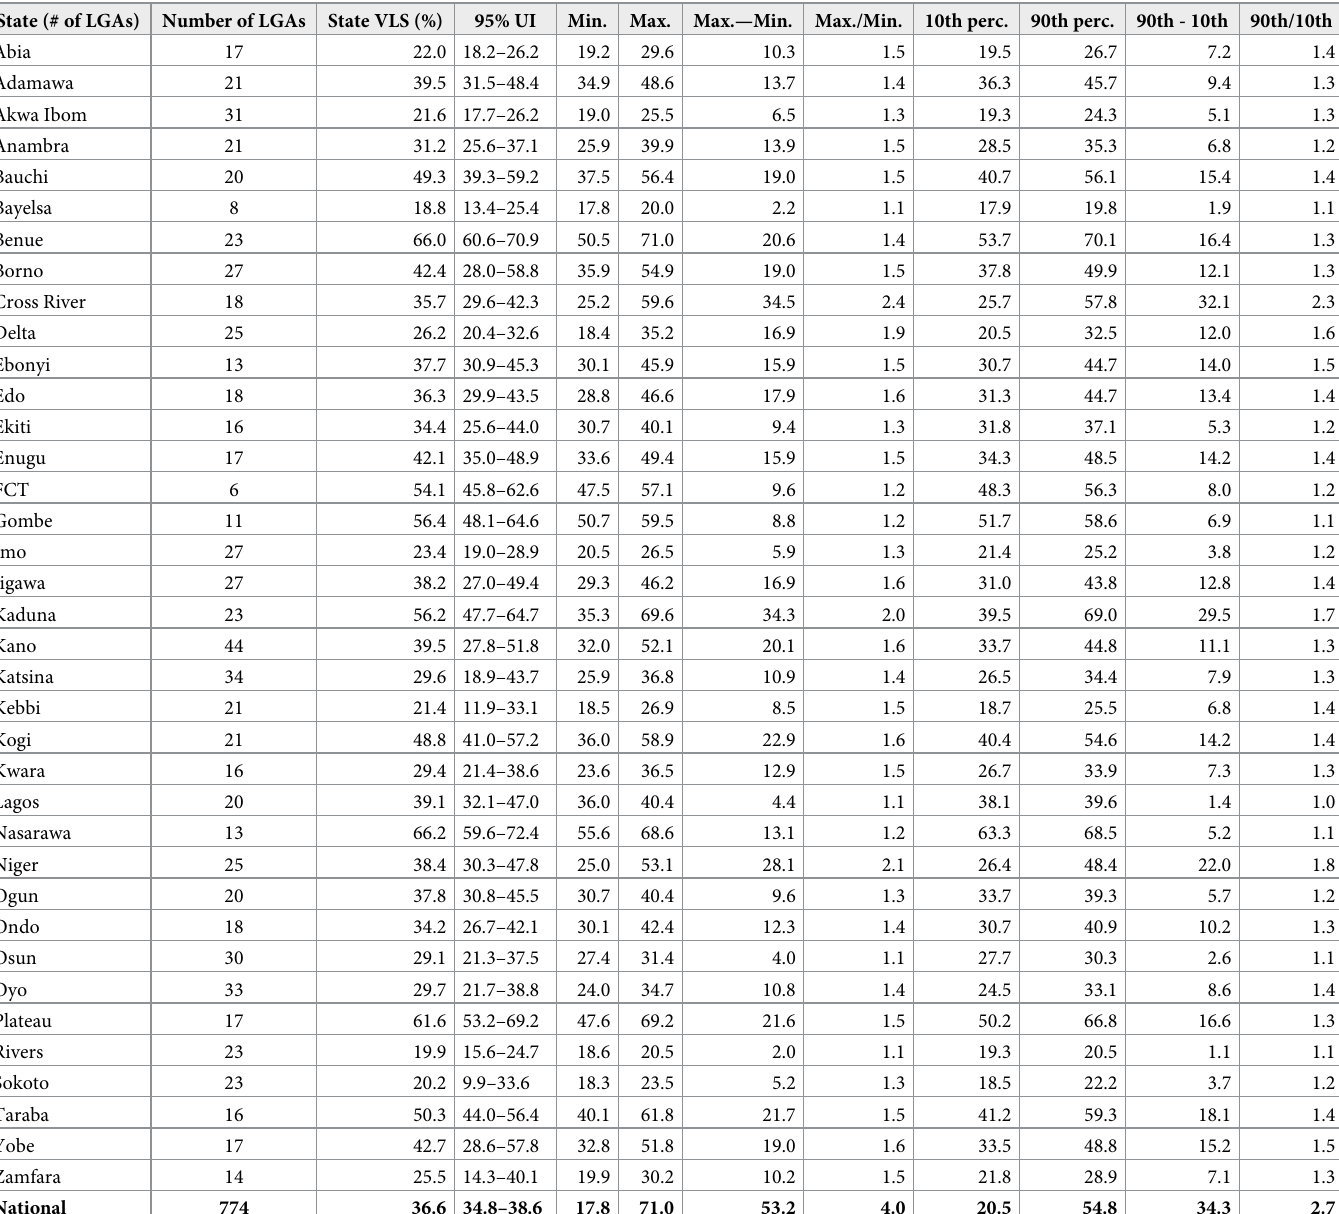
Table 5. Differences in viral load suppression among people living with HIV between local government areas within states in Nigeria (2018). State (# of LGAs) Number of LGAs State VLS